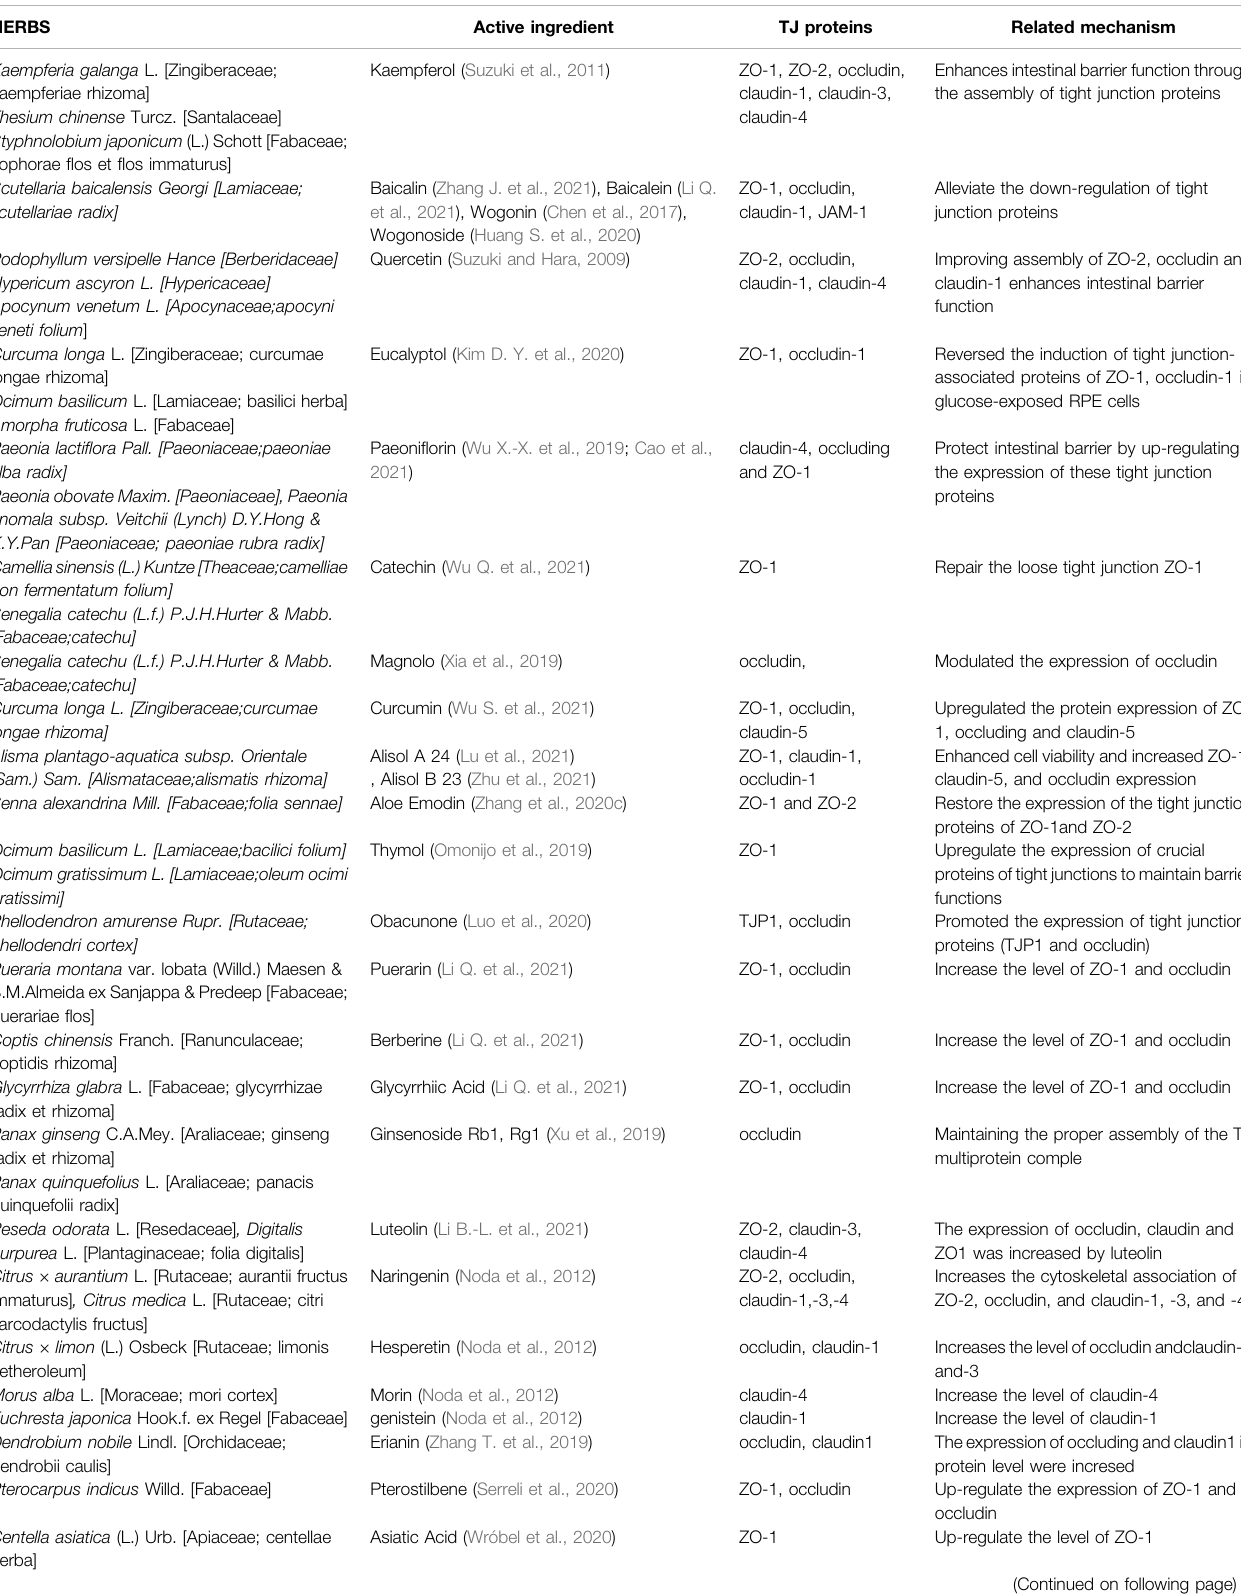
TABLE 2 | Herbs for the treatment of COVID-19 that can affect the expression of tight junction proteins